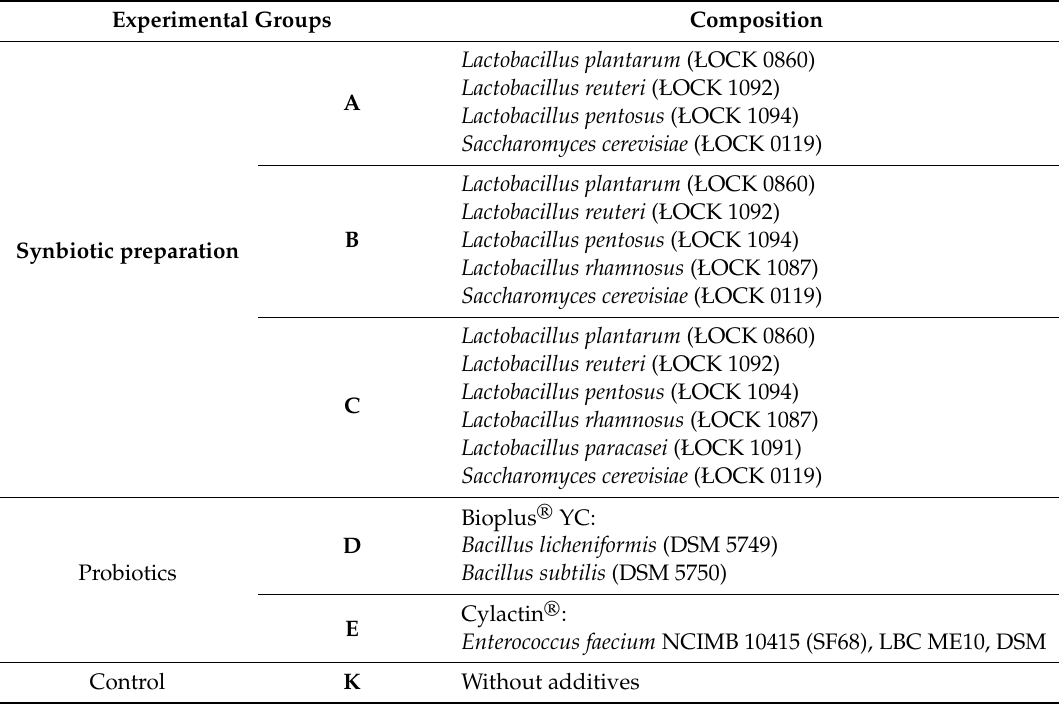
Table 1. Experimental group